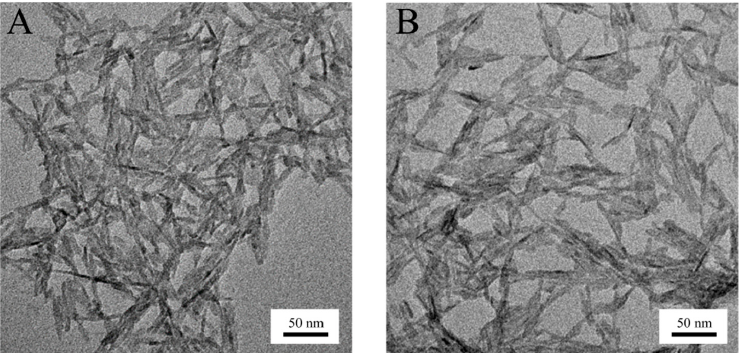
Figure 8. TEM micrograph of ( A ) run 5 and ( B ) run 2 samples.